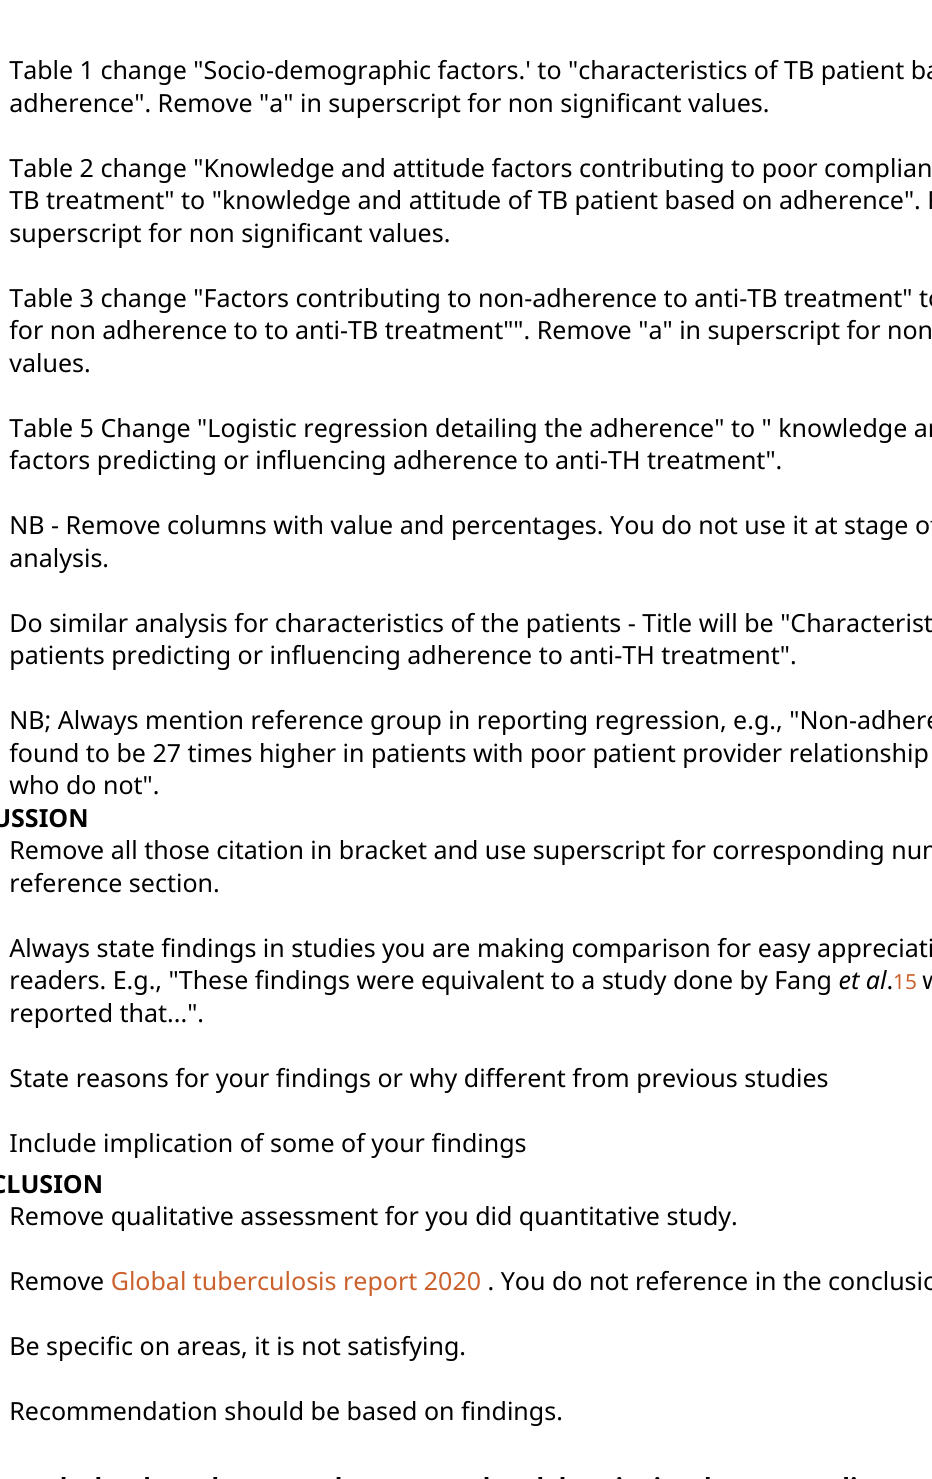
Table 1 change "Socio-demographic factors.' to "characteristics of TB patient based on adherence". Remove "a" in superscript for non significant values. Table 2 change "Knowledge and attitude factors contributing to poor compliance with anti- TB treatment" to "knowledge and attitude of TB patient based on adherence". Remove "a" in superscript for non significant values. Table 3 change "Factors contributing to non-adherence to anti-TB treatment" to" Reasons for non adherence to to anti-TB treatment"". Remove "a" in superscript for non significant values. Table 5 Change "Logistic regression detailing the adherence" to " knowledge and attitude factors predicting or influencing adherence to anti-TH